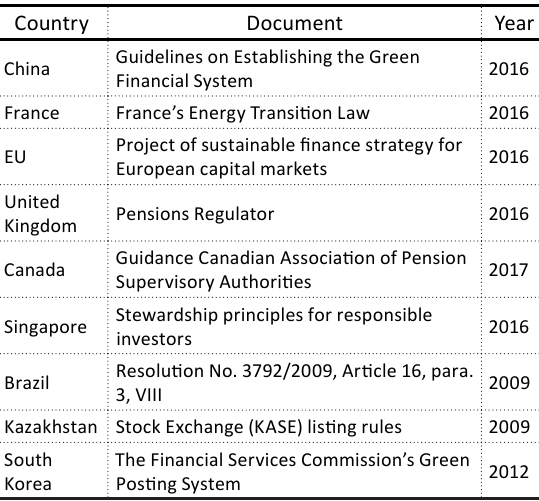
Table 1. Countries’ experience in ESG investment process